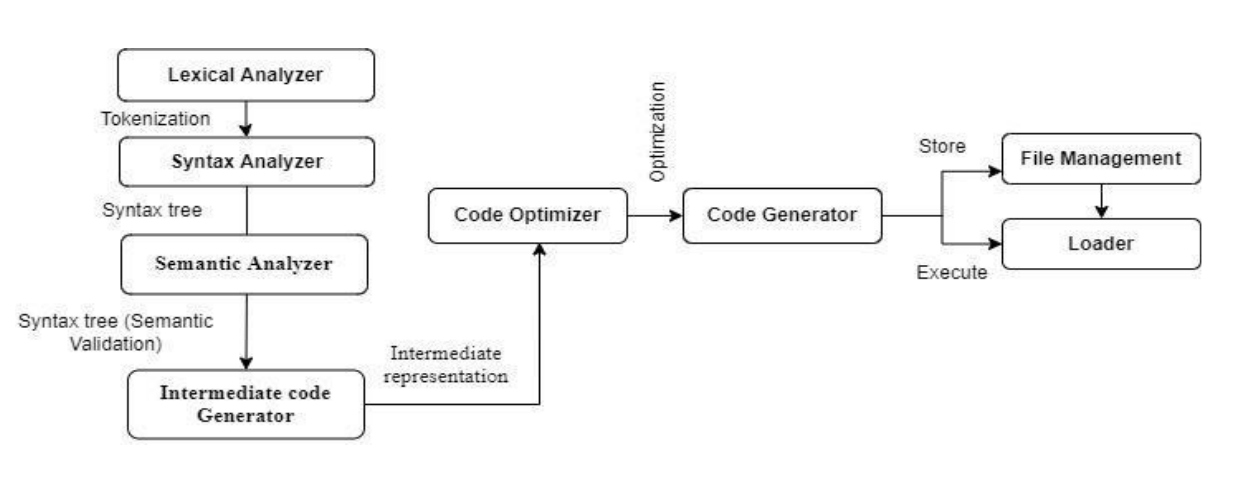
Figure 1. Compilation Process